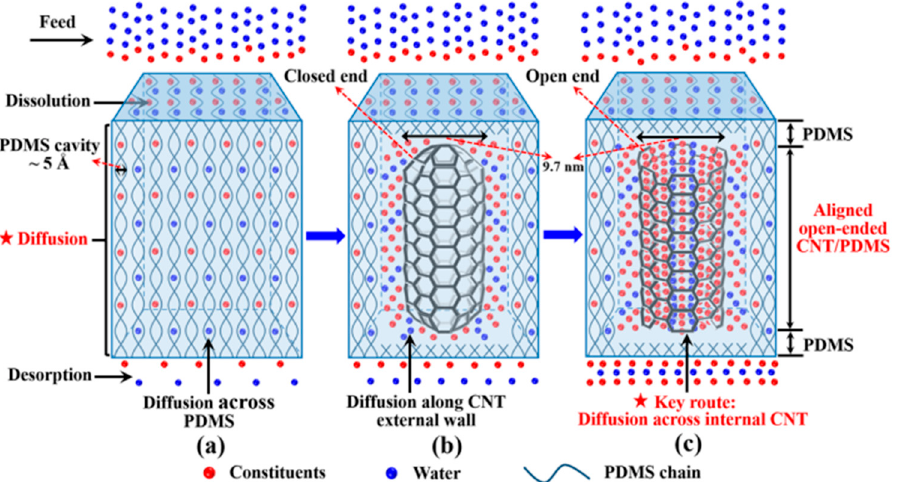
Figure 10. Schematic of the mechanism of molecule transport ( a ) The pure PDMS membrane; ( b ) the aligned CNT (closed-ended)/PDMS membrane; ( c ) the aligned CNT (open-ended)/PDMS membrane.